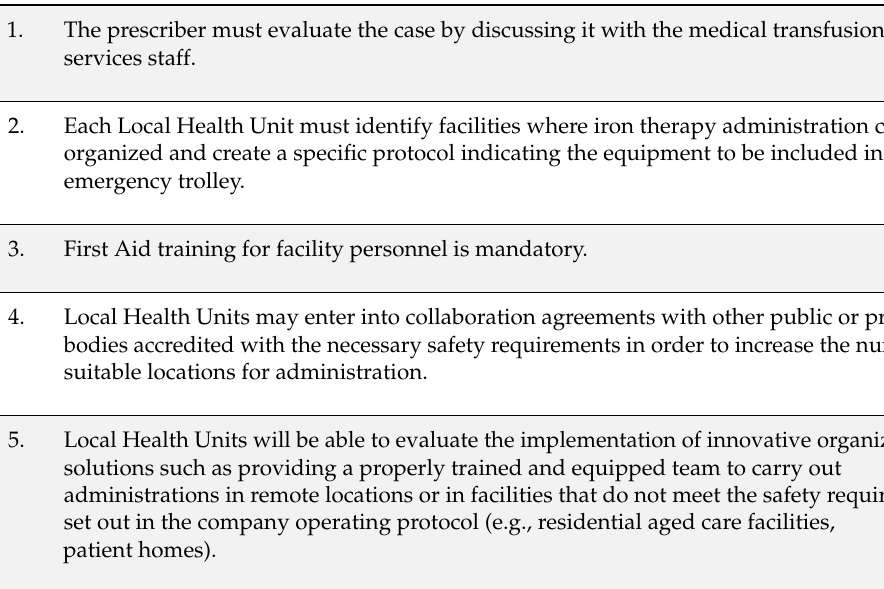
Table 2. Synopsis of management strategies for intravenous iron